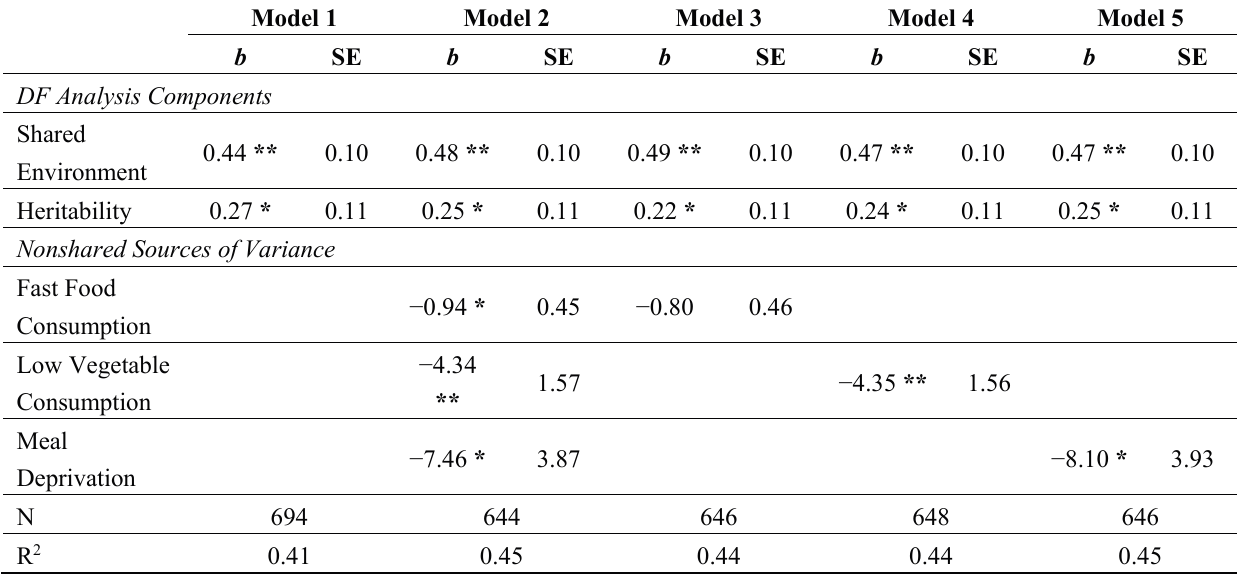
Table 2. DF analysis of the shared environment, heritability, and adolescent nutritional factors as predictors of verbal intelligence during early adulthood verbal intelligence (wave